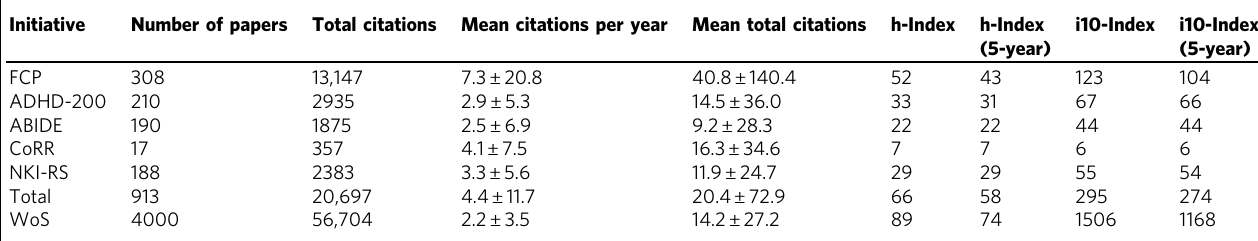
Table 1 Quantifying impact of INDI efforts using common publication-based indices